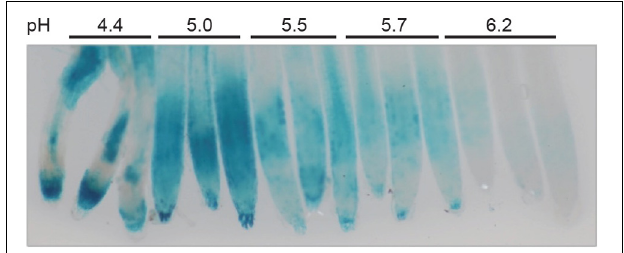
FIGURE 3 | ALMT1 is expressed under acidic pH independently from the presence of Al. Seedlings were grown in hydroponic solution at the indicated pH in phosphate-rich condition (P 500 ) for 3 days. A total of 7 plants were transferred in a 30 mL fresh solution at the indicated pH for 12 h before GUS staining for 1